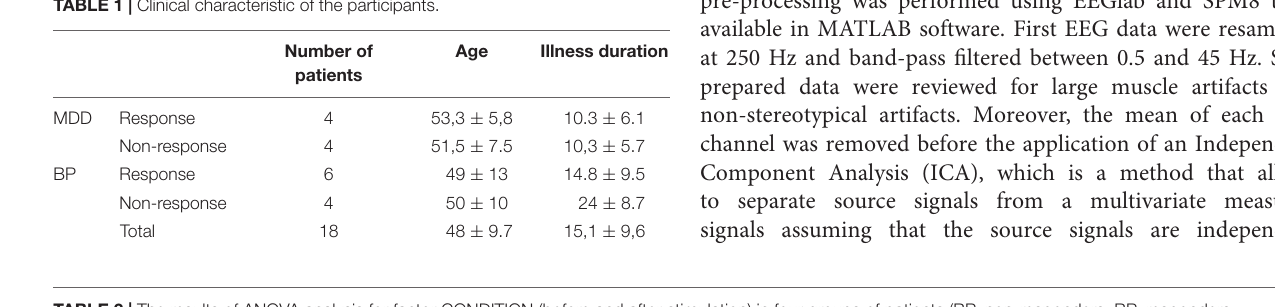
TABLE 2 | The results of ANOVA analysis for factor CONDITION (before and after stimulation) in four groups of patients (BP_non-responders, BP_responders, MDD_non-responders, MDD_responders).